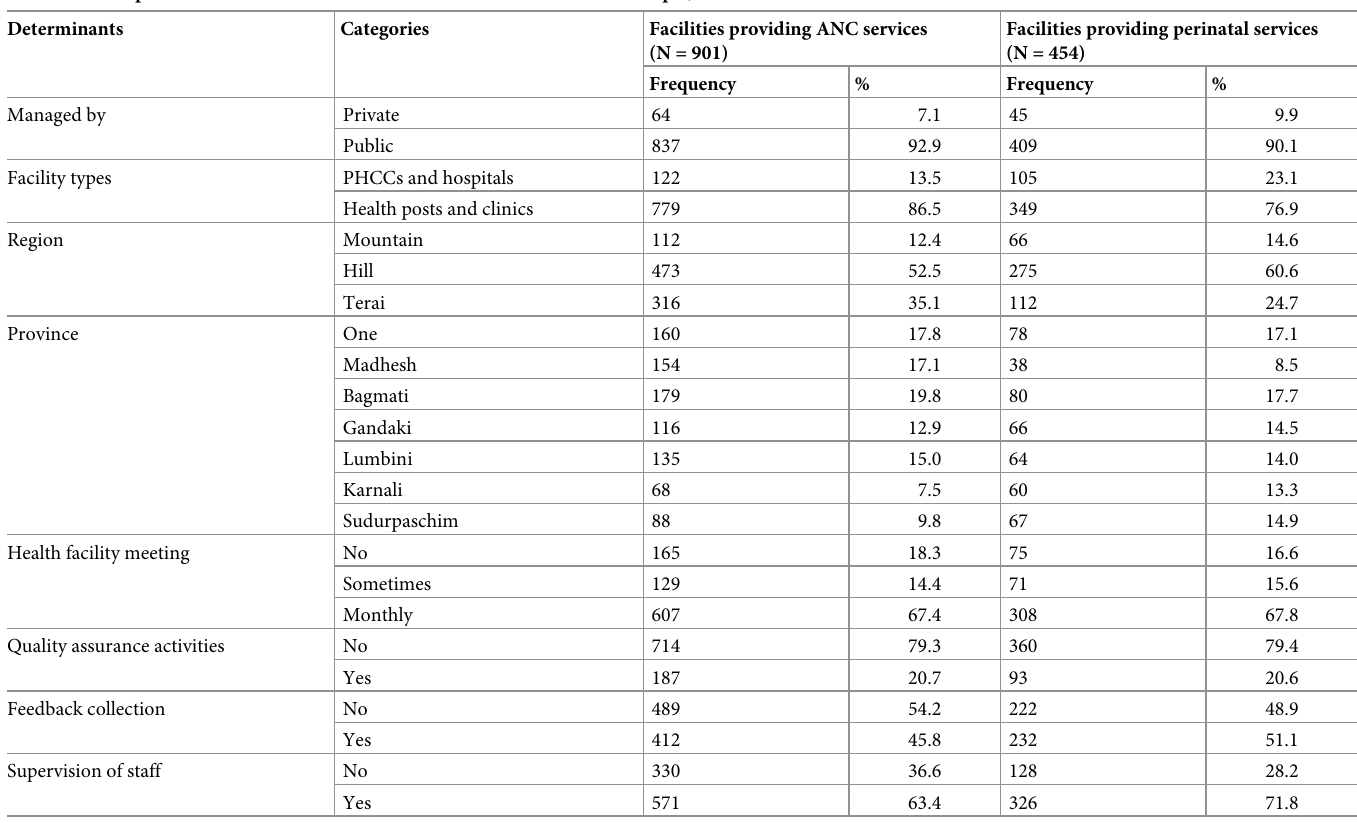
Table 1. Descriptive characteristics of health facilities with MNH services in Nepal,